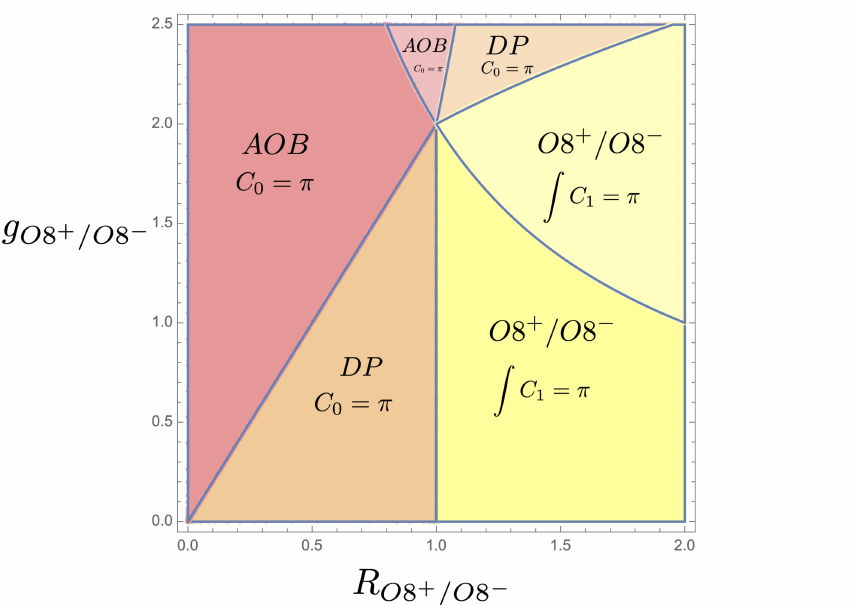
Figure 4 . Depiction of the new component of the nine-dimensional rank one moduli space. As described in the main text, it is fully covered by versions of the Dabholkar Park, AOB, and O 8 + /O 8 − compactifications with discrete theta angles turned on. As in figure 3 we used the O 8 + /O 8 − component to parametrize all of moduli space. The only difference with figure 3 is the scale of the vertical axis, reflecting the rescaling (3.47). Relatedly, the self-dual point is at coupling g the duality group is Γ (2) instead of the SL (2 , Z ) that one obtains when the discrete theta angle is 1 switched